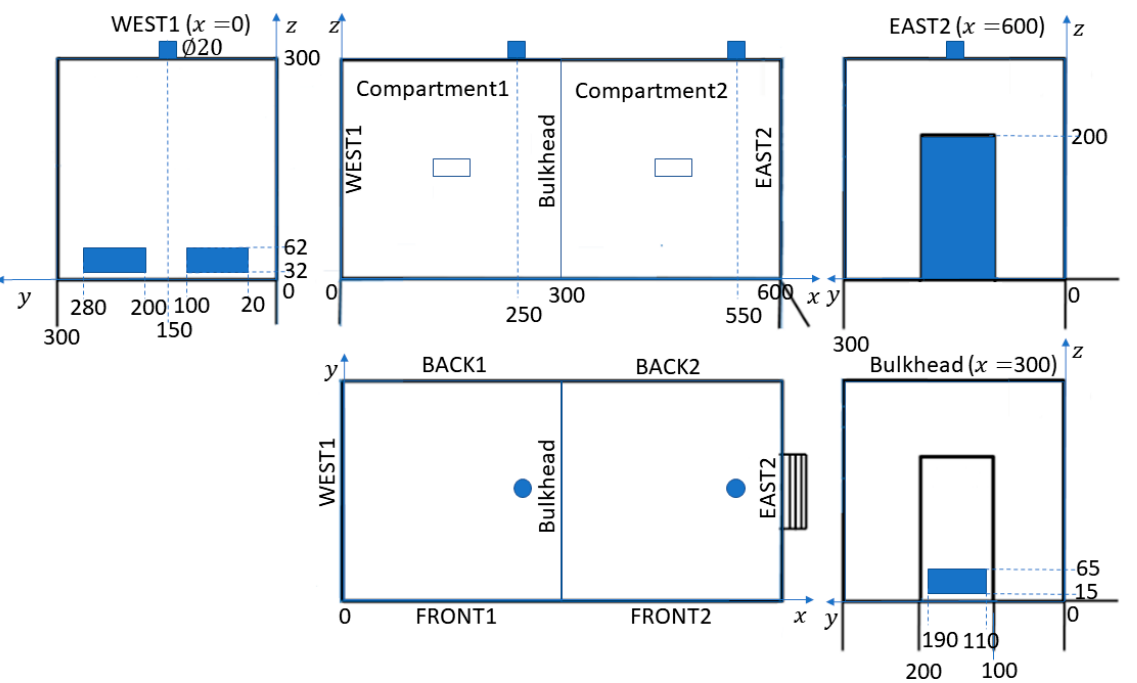
Figure 6. Exploded view of the DIAMAN device (dimensions in cm).